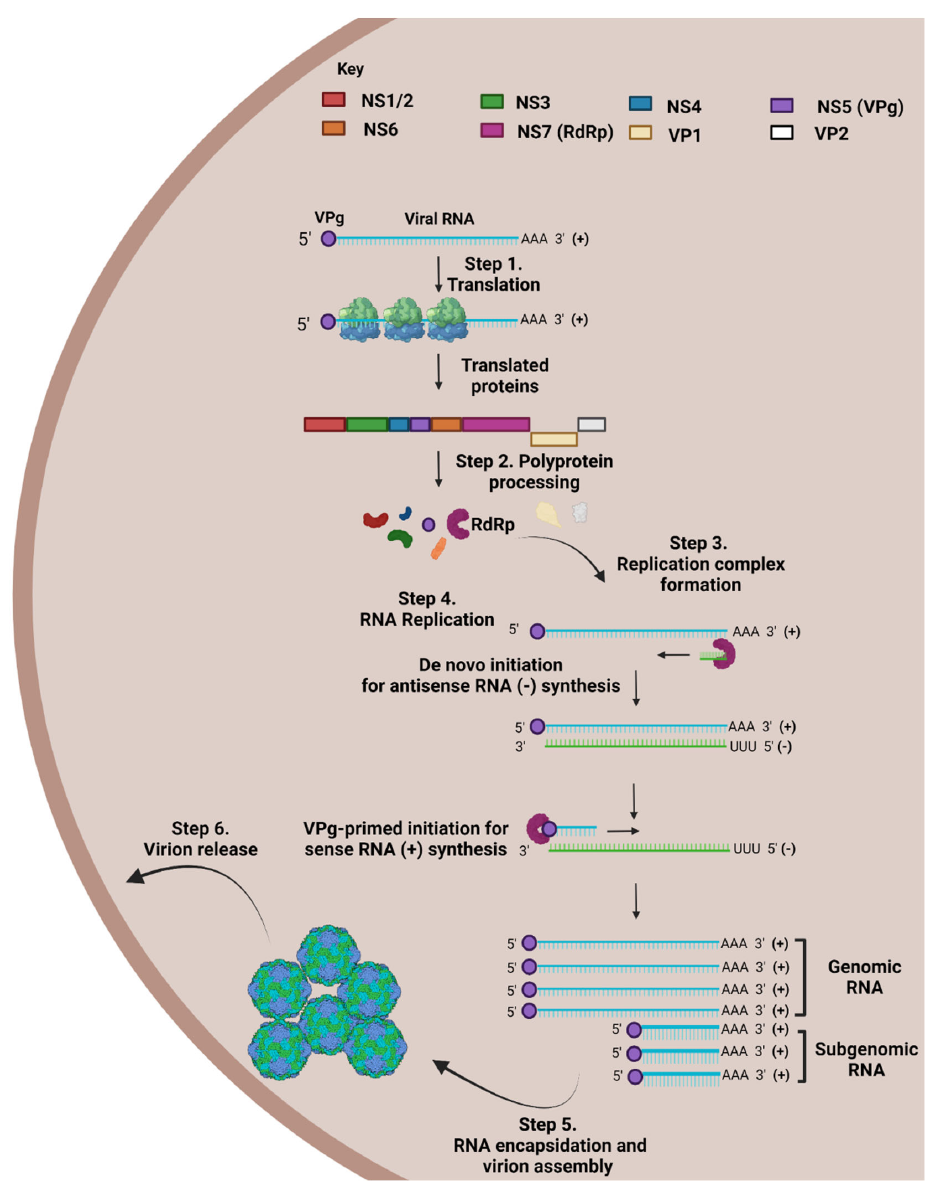
Figure 4. NoV RNA replication model. NoV genome is a positive sense RNA strand, which is translated to give rise to NoV proteins. The replication of the positive RNA strand occurs through two initiation steps. De novo initiation occurs at the 3 ′ of viral genome resulting in the formation of an antisense RNA strand ( ‐ ) using RNA ‐ dependent RNA ‐ polymerase (RdRp) NS7. This antisense strand is used as a template for the formation of a sense through VPg ‐ primed initiation using RdRp again. Resulting genomic and subgenomic viral RNA undergoes encapsidation into virions, which are released from the cell. Made using Biorender.com accessed on 18 October 2022 .